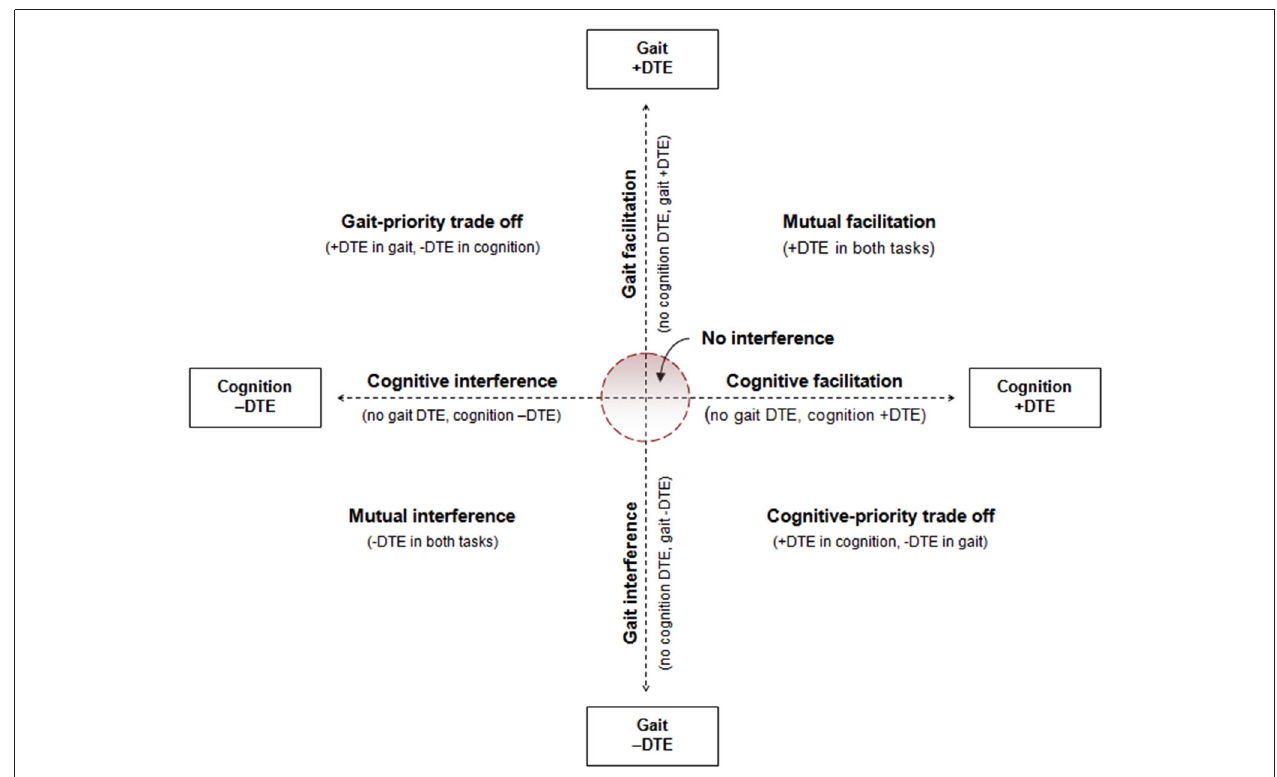
FIGURE 1 | Illustration of conceptual model for characterizing patterns of cognitive-motor dual-task interference . Figure is from Plummer et al. (2014), and adapted from conceptual framework of Plummer et al.